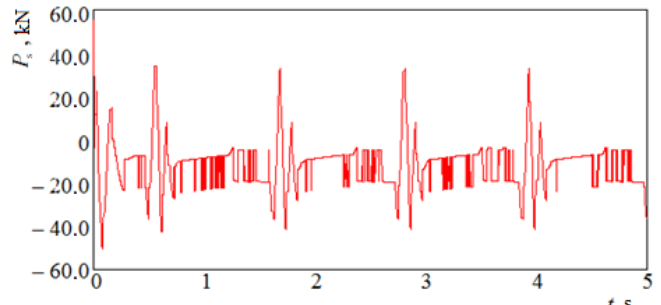
Figure 15. Forces in spring suspension.